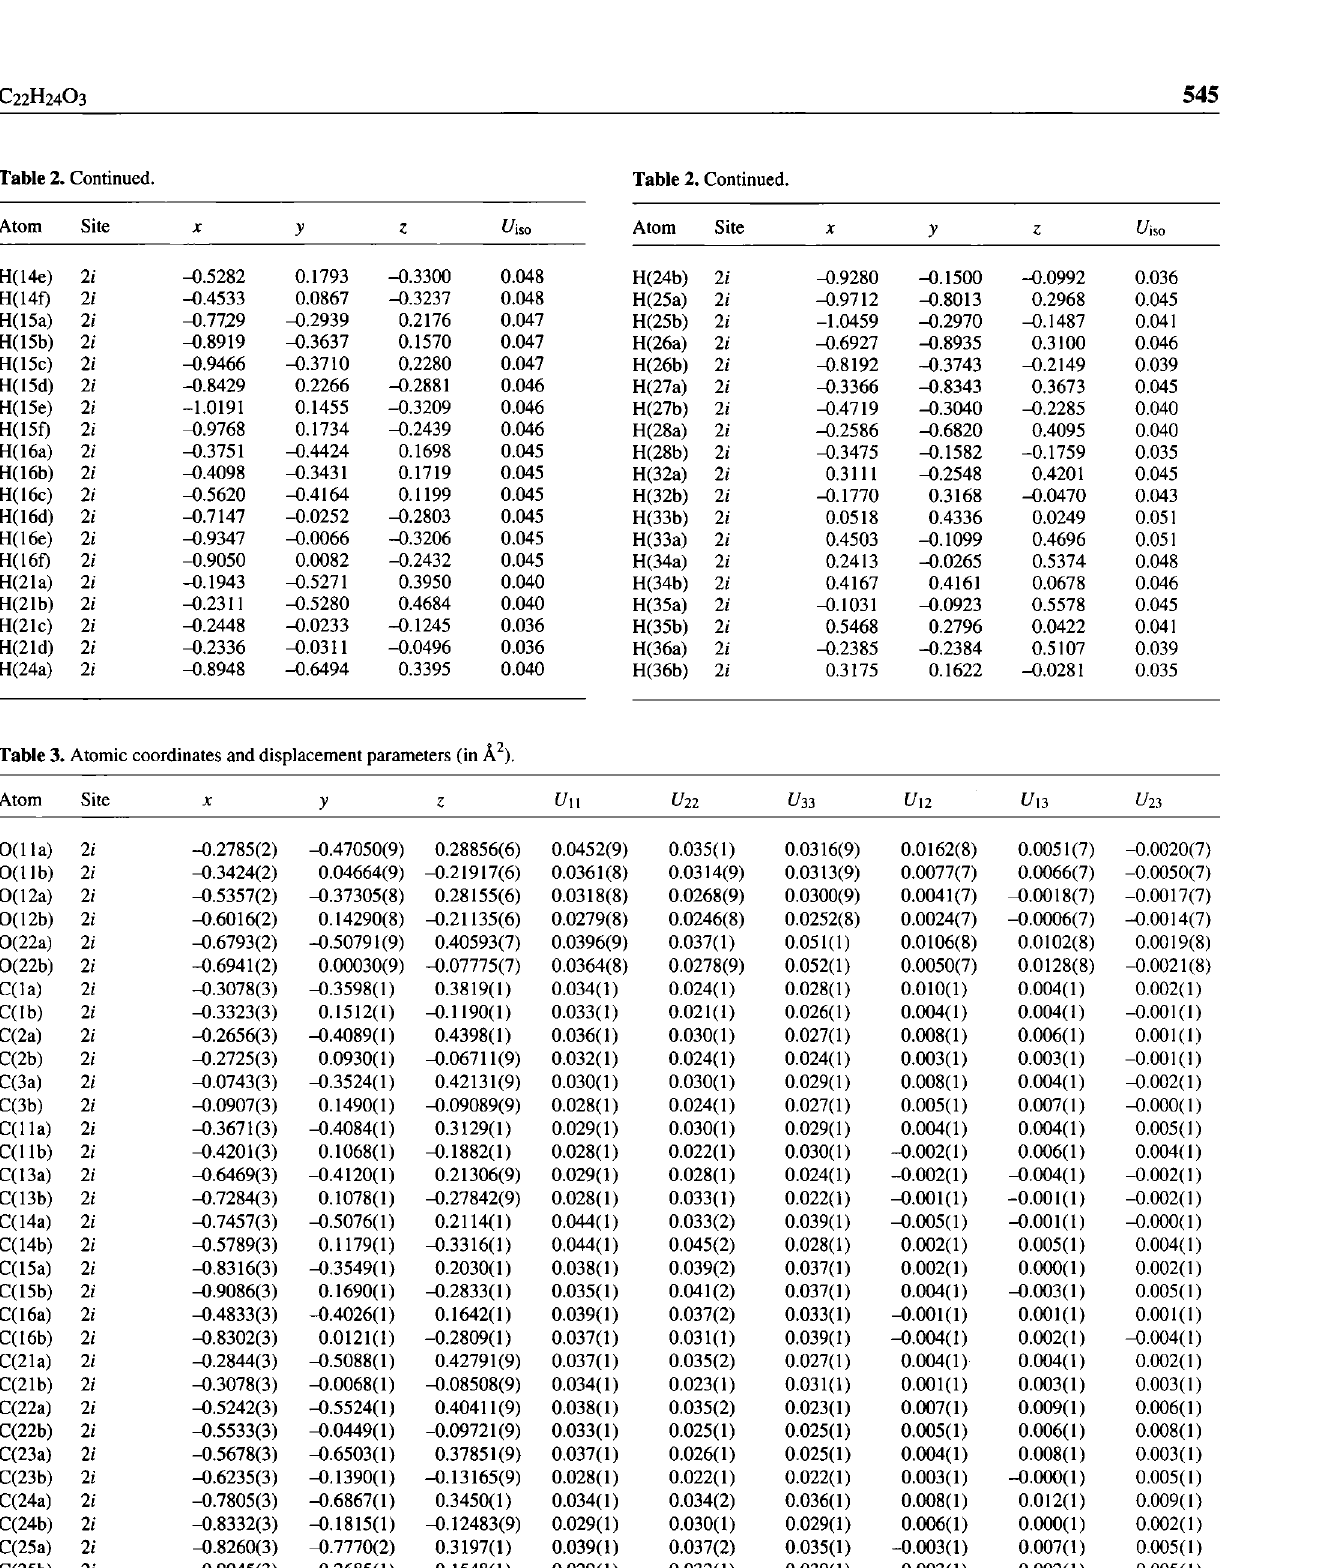
Table 3. Atomic coordinates and displacement parameters (in À 2